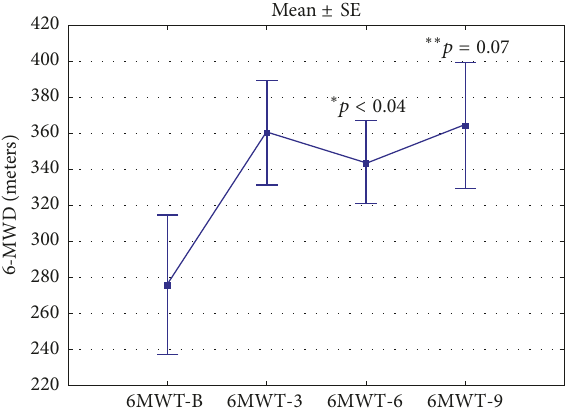
Figure 2: 6-minute walk test distance (6-MWT) at baseline, 3 months, 6 months, and 9 months after initiation of PAHST.